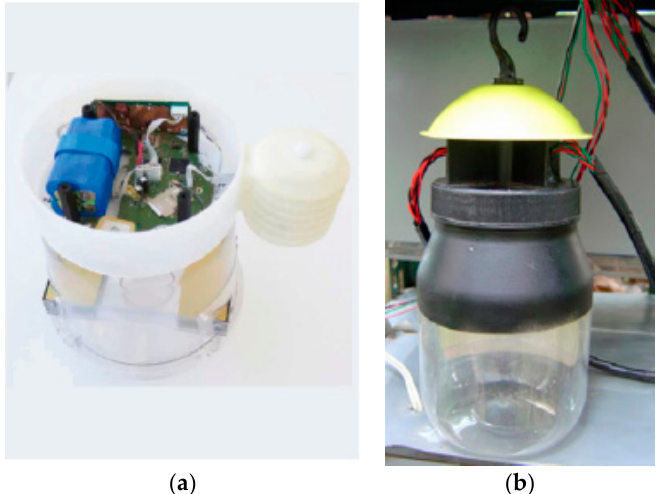
Figure 2. Electronic traps: conventional traps converted to automatic fruit fly monitoring units. McPhail trap equipped with fresnel lens ( a ) [49]. Automatic trap with infrared sensor for Bactrocera dorsalis ( b ) [2].